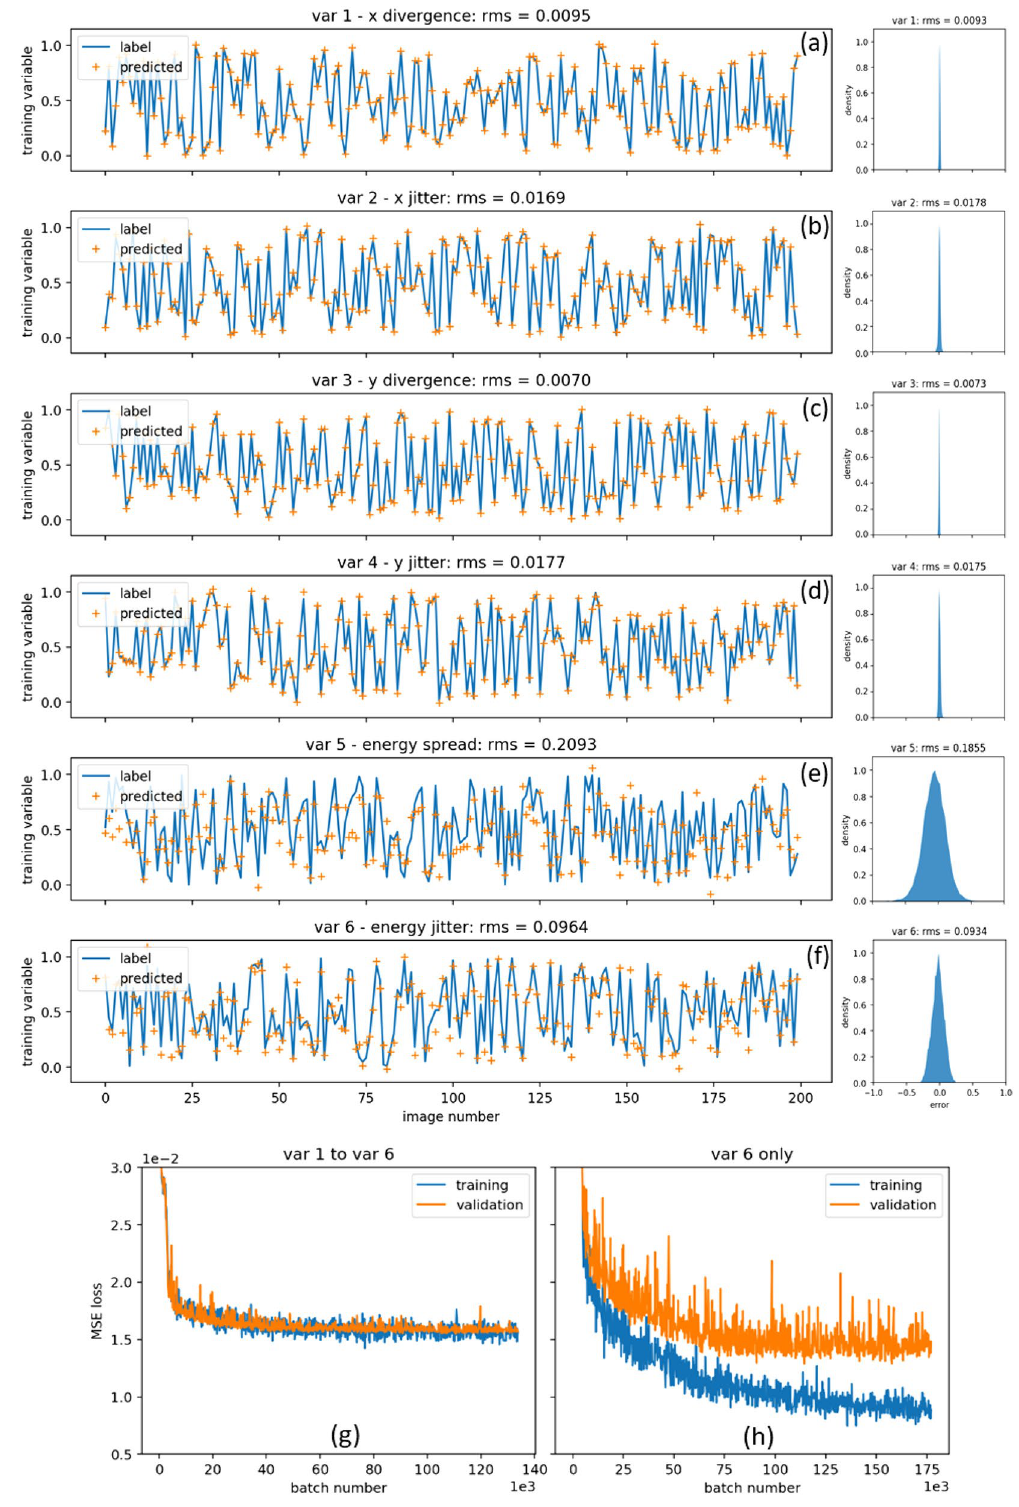
Figure 3. The training variables 1 ( a ), 2 ( b ), 3 ( c ), 4 ( d ), 5 ( e ), and 6 ( f ) as input to generate the BD patterns are plotted as the blue curve while their corresponding predictions by the ML model are plotted as the orange crosses for the untrained 200 images. Besides, the corresponding error distributions for the entire dataset of 10,000 images are plotted on the right side. The RMS errors for the untrained images and the entire dataset agree well. ( g ), ( h ): training loss (blue curve) and validation loss (orange curve) are plotted for two different cases, six training variables ( v 1 to v 6) trained together and only variable v 6 being trained, respectively. Notice the different x scaling for (g) and (h). The fluctuation of the loss curves for the variable v 6 only is larger than the 6 variables due to the smoothing effect introduced by averaging the mean squared error (MSE) loss over all the variables in the 6-variable